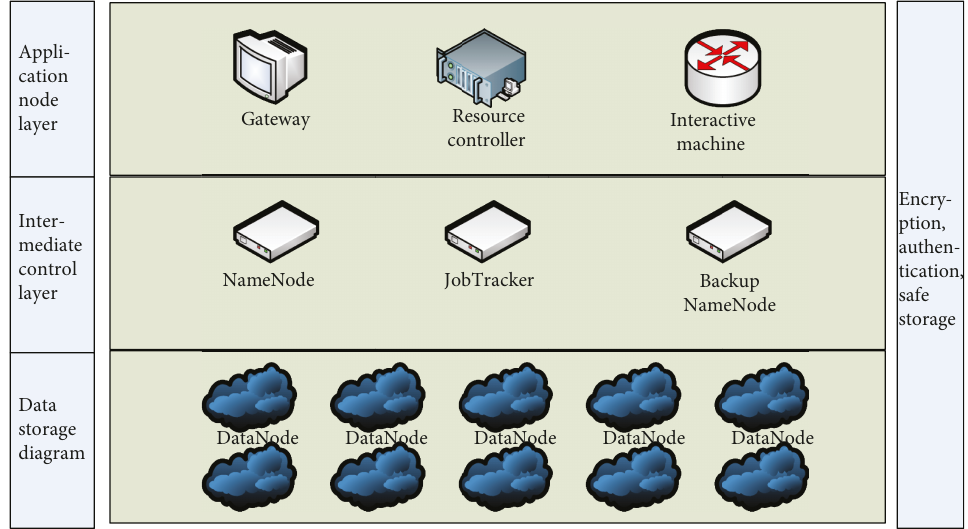
Figure 1: Cloud platform system based on Hadoop